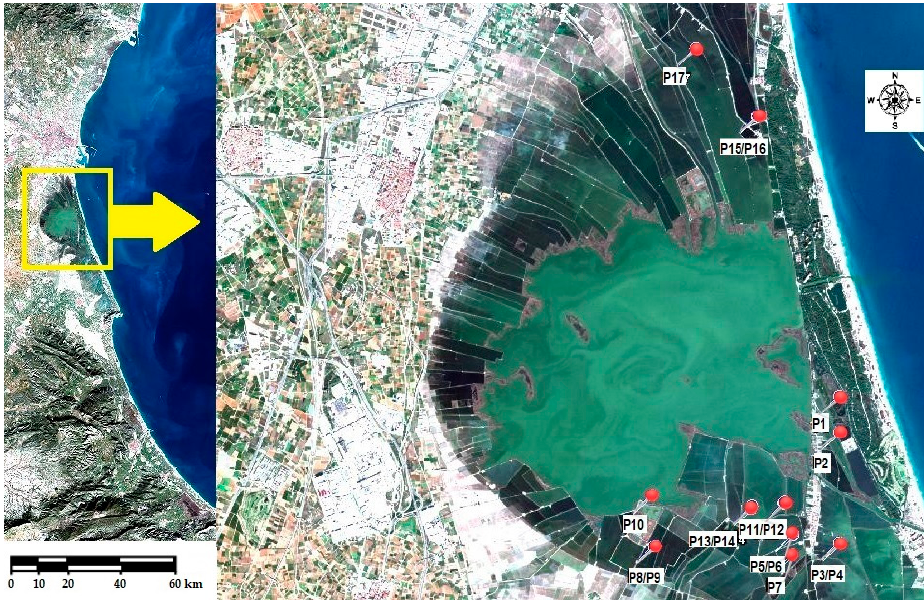
Figure 3. Marshes site sampling location in Albufera of Valencia Natural Park from an RGB composition of the S2 image dated 5 January 2021.